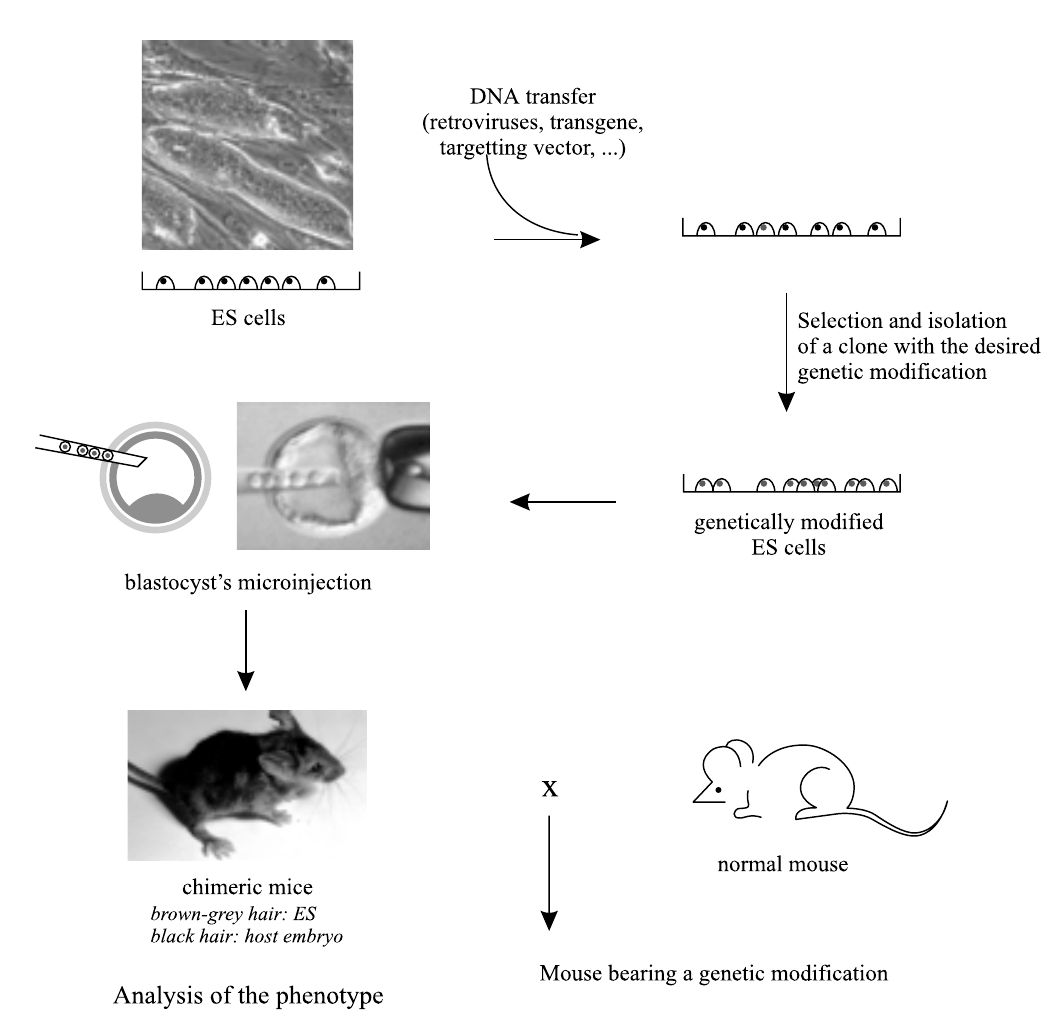
Fig. 1 – The different stages in the creation of genetically modified mice via ES cells.